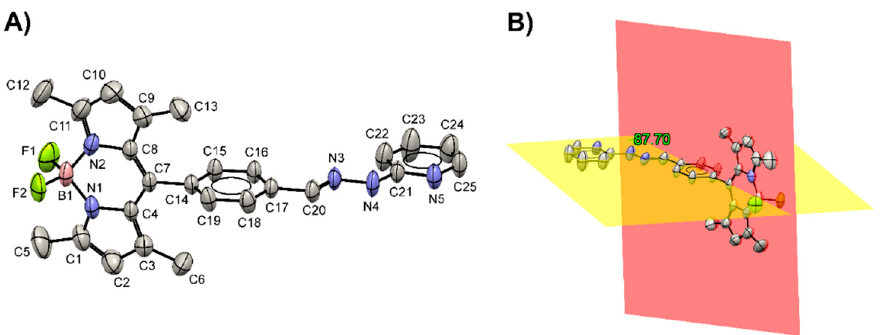
Figure 2. ( A ) The ORTEP plot showing the molecular structure of BODIPY-PH together with a non-IUPAC atom-labeling scheme. Displacement ellipsoids are drawn at the 50% probability level (CCDC No. 2040756). ( B ) The mean planes constructed from 12 atoms (C1–C4/C7–C11/N1–N2/B1; red plane) and 6 atoms (C14–C19; yellow plane) are roughly perpendicular to each other.